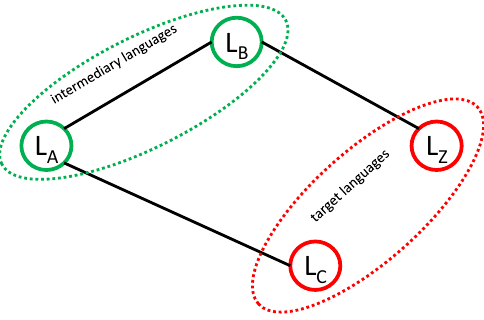
Figure 3. Example of mediator selection from the intermediary languages.